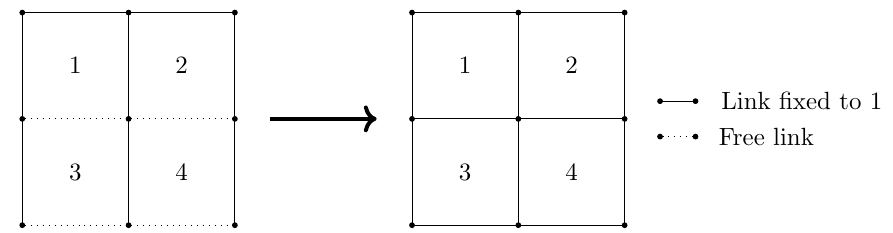
Figure 10 . Impossibility of minimizing, at the same time, the contributions from the loops of size one and the contributions from the loops of size 2 when β 1 > 0 and β 2 < 0 . Starting from a gauge fixed configurations with all the links set to I except for one per plaquette, we minimize the action for the loop of size one by imposing Tr hand-side. This configuration is clearly incompatible with the condition Tr to minimize the action for loops of size two on its